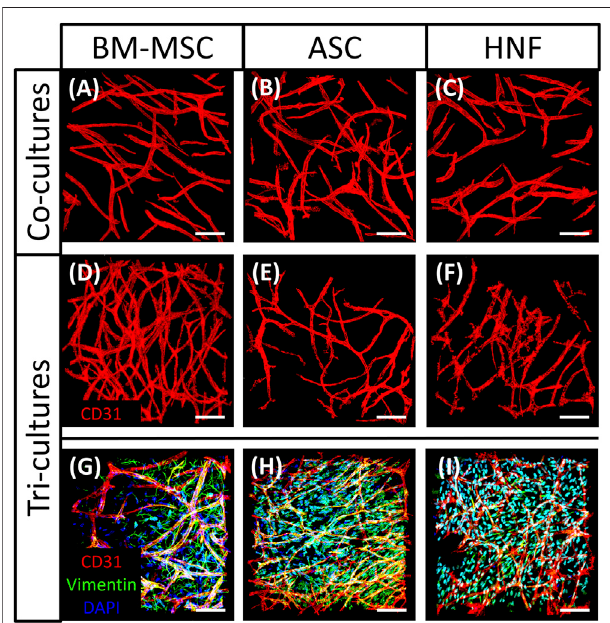
FIGURE 6 | TPLSM images of co-cultures with HUVEC and tri-cultures. (A – C) : CD31-staining showed comparable vascularization in co-cultures of HUVEC with BM-MSC (A) , ASC (B) or HNF (C) (D – F) : larger networks of vascular-like structures were found in tri-cultures with BM-MSC (D) in comparison with ASC (E) and HNF (F) (G – I) : vimentin-staining showed distribution of supporting cell types in a selection of tri-culture-samples with BM-MSC (G) , ASC (H) or HNF (I) . Scale bar: 50